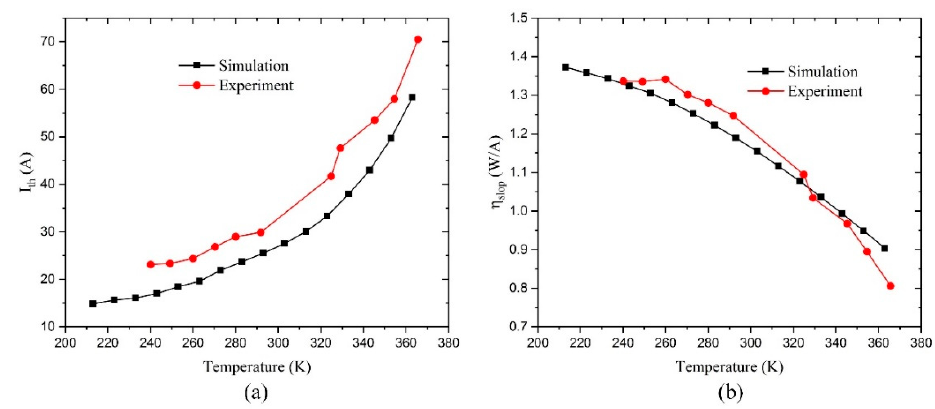
Figure 11. Comparison of simulated and experimental data of: ( a ) the threshold current, ( b ) the slope efficiency.